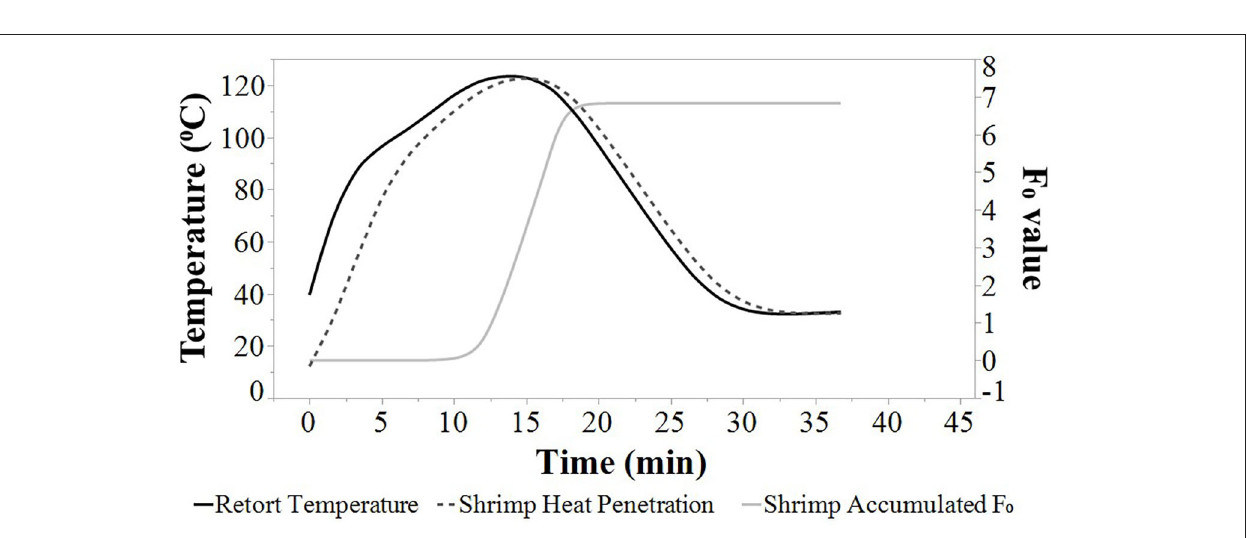
FIGURE 4 | Average retort temperatures (solid black), heat penetration curves (dotted black), and accumulated F 0 (solid gray) values for Louisiana Gulf Coast (LGC) brown shrimp during retort thermal processing at 180 SPM. JMP smoother function was used to construct all figure lines.